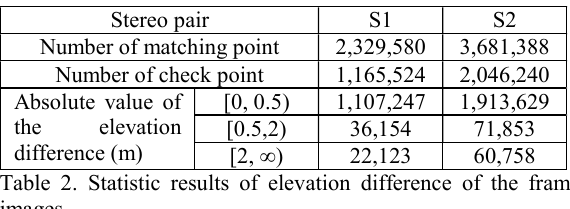
Figure 6. Matching result of S2 and comparison with LiDAR, where (a) and (b) are the base and matching images of the stereo pair, respectively, and the areas within the dashed boxes represent the overlapping of the image pair; (c) is the point cloud of LiDAR (the coloring is the same as that in Figure 5(c)); (d) is the result of our method (the coloring is the same as that in Figure 5(c)); (e) is the enlarged view of the area in the blue rectangle of (a), which has no LiDAR point (as shown in the blue rectangle in (c)); (f) is the enlarged view of the area in the red rectangle of (a) and is also the base image of the unmatched area in the red rectangle of (d); (g) is the enlarged view of the area in the white rectangle of (d); (h) is the enlarged view of the same area of (g), but the LiDAR point (the blue point) and our result (yellow point) are put together; (i) is a profile of the purple line in (h). (Note: The LiDAR is captured in strip, so that a strip change is evident in (c)).